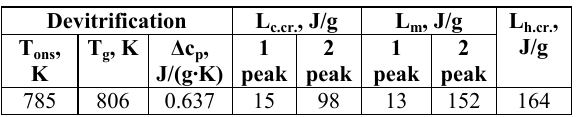
Table 1. Values of heat effects at the sample cooled at the rate of 900 K/s.